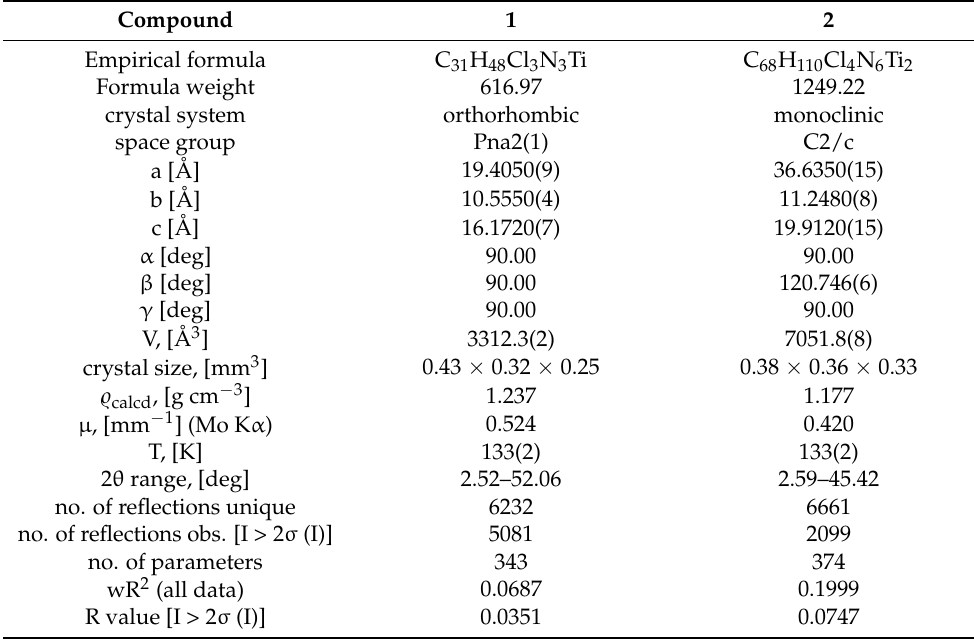
Table 1. Crystallographic data of the compounds 1 and 2